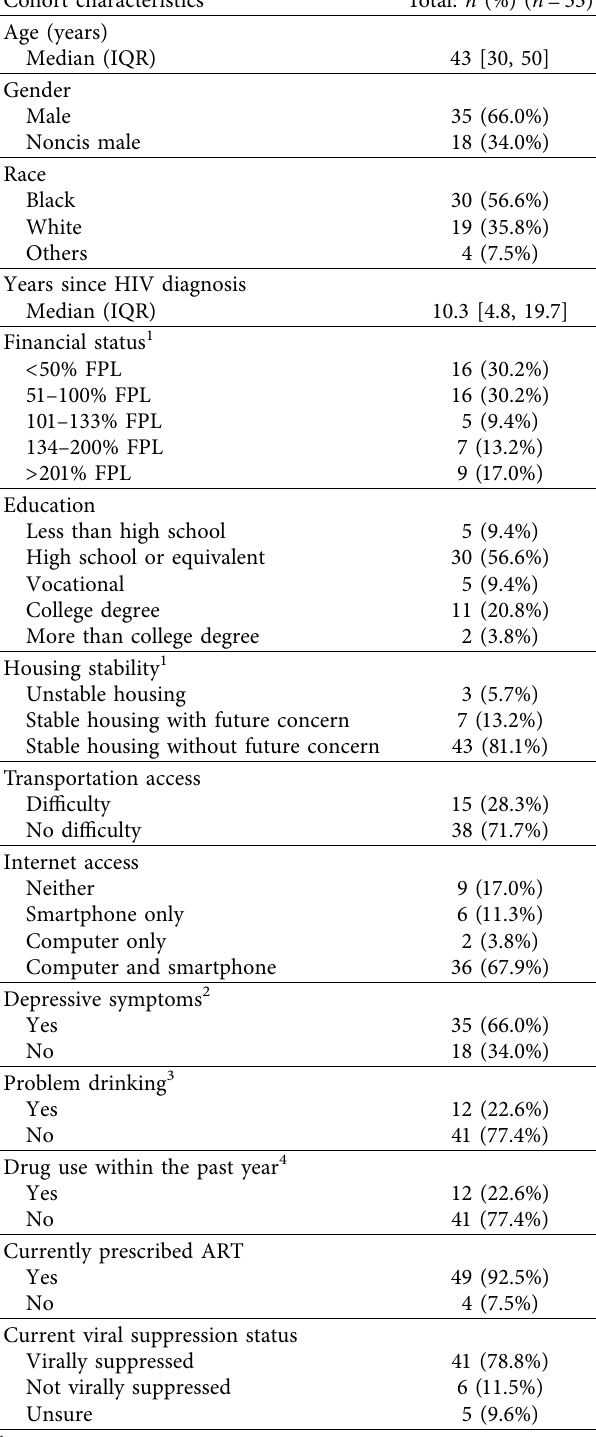
Table 1: Baseline